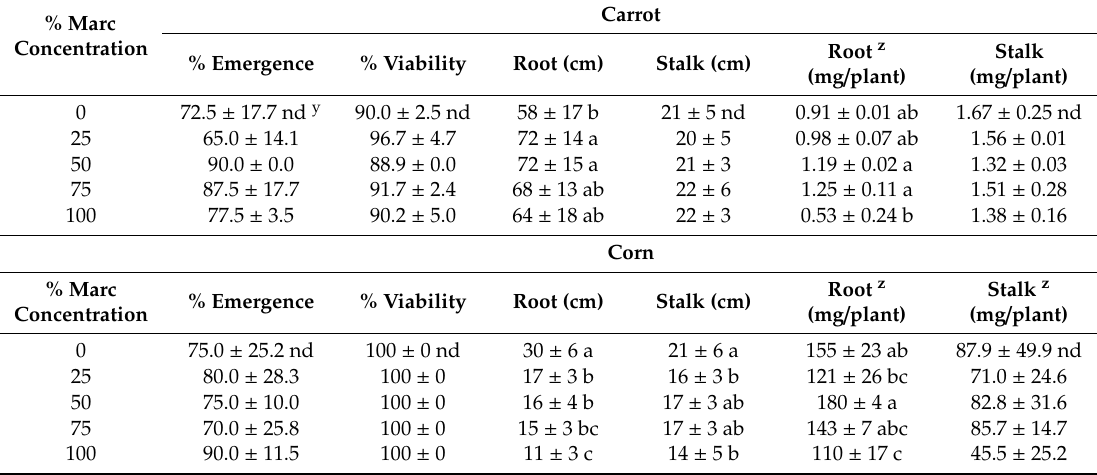
Table 2. Seedling emergence data of carrot ( n = 2) and corn plants ( n = 4) in compost and depleted grape marc